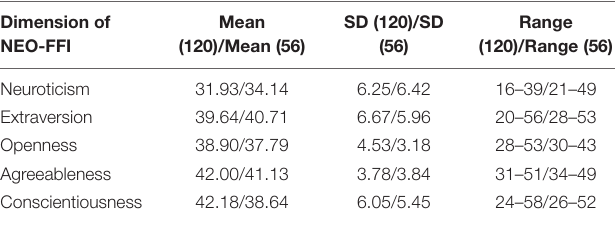
TABLE 2 | Descriptive statistics for the NEO-FFI scores of all participants in the two samples. Dimension of NEO-FFI